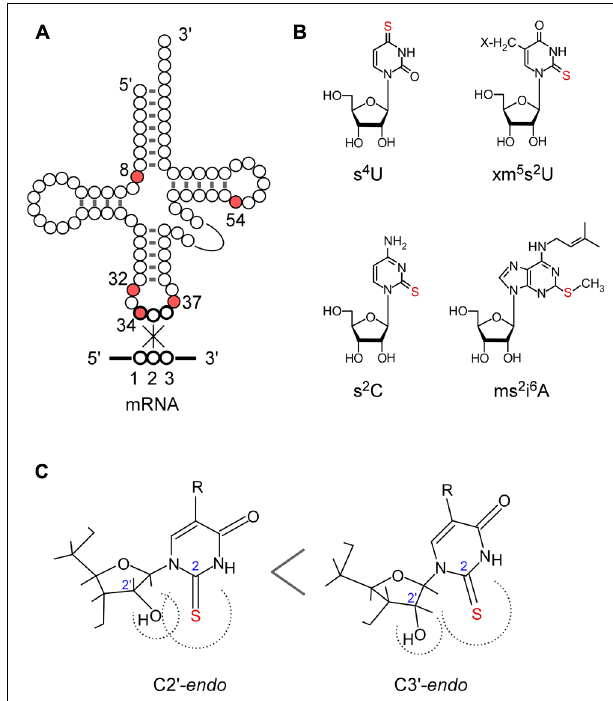
FIGURE 1 | Sulfur-containing tRNA modifications. (A) Secondary structure of tRNA and positions of thiolated nucleosides in tRNA. (B) Chemical structure of thiolated nucleosides in E. coli : s 4 U, 4-thiouridine; s 2 C, 2-thiocytidine; xm 5 s 2 U, 5-methyl-2-thiouridine derivatives; ms 2 i 6 A, 2-methylthio- N 6 -isopentenyladenosine. (C) Conformation of the xm 5 s 2 U: C3’ -endo form is preferred because of the steric hindrance of the 2-thio and 2’ -OH groups.